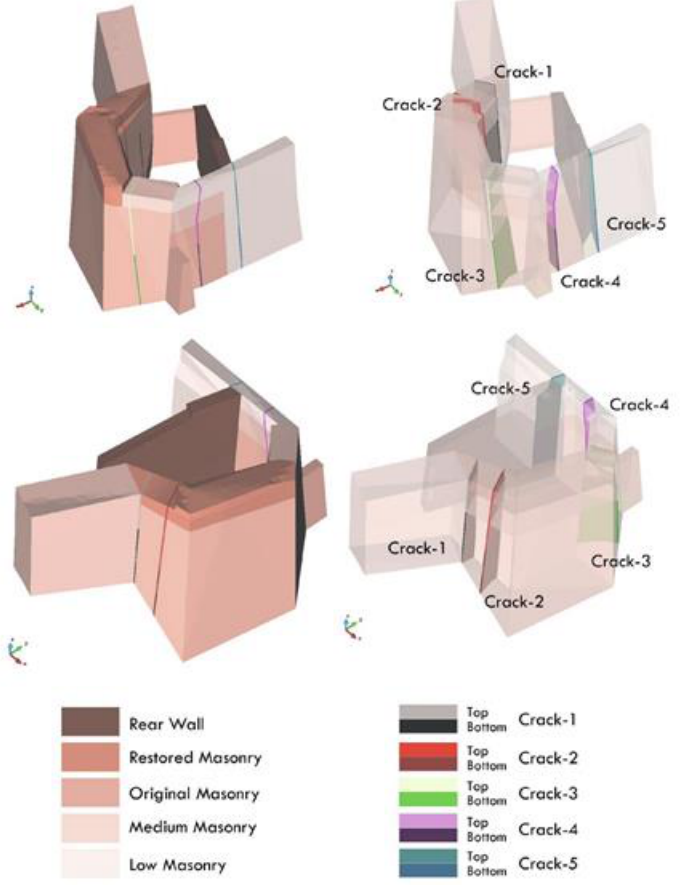
Figure 21. Model of the simulated tower showing the location of the different types of masonries and cracks.